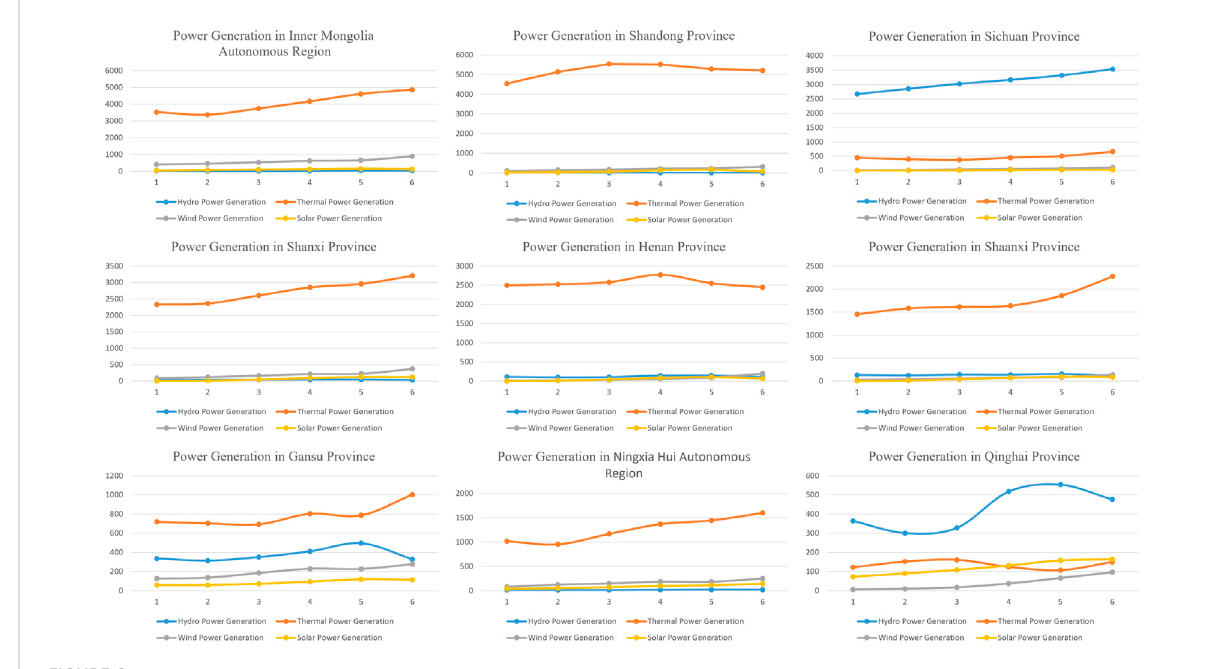
FIGURE 8 Change trend of energy structure in the Yellow River basin from 2015 to 2021.